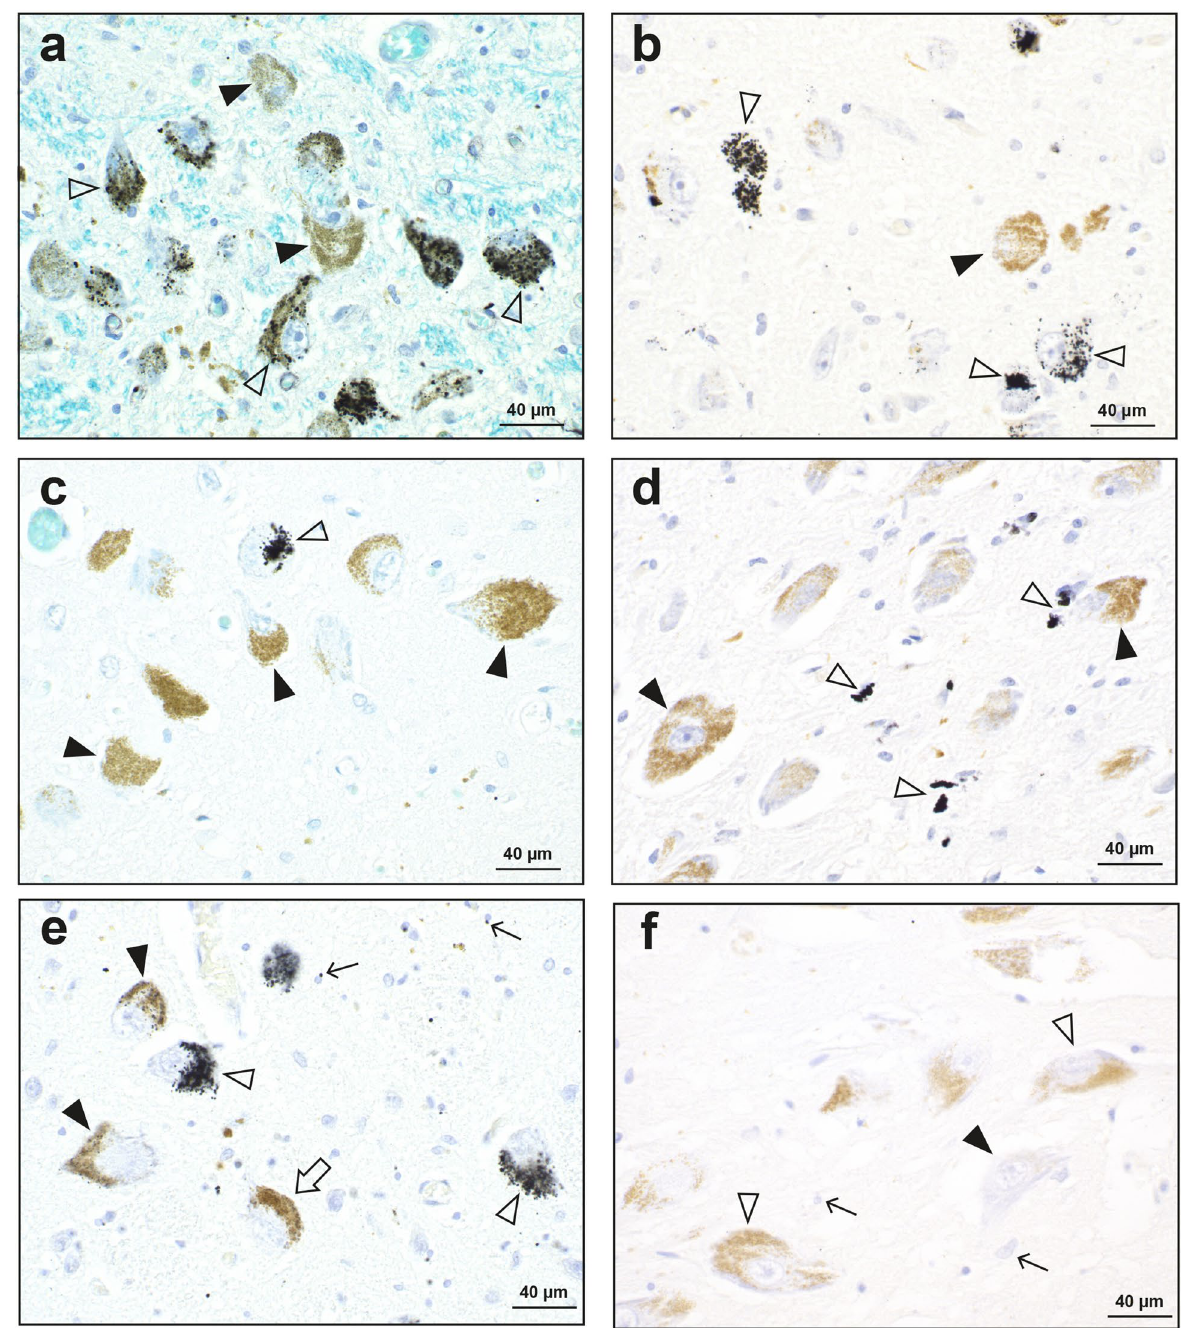
Figure 4. Autometallography of the locus ceruleus. ( a ) Black AMG PTE granules are seen in the majority of locus ceruleus neurons (open arrowheads). Some locus ceruleus neurons contain no AMG PTEs (closed arrowheads). MS18. AMG/LFB/CV. ( b ) Many locus ceruleus neurons contain AMG PTE granules (open arrowheads). Some locus ceruleus neurons contain no AMG PTEs (closed arrowhead). MS09. AMG/H. ( c ) A few locus ceruleus neurons contain AMG PTEs (arrowhead). Most locus ceruleus neurons do not contain AMG PTEs (closed arrowheads). MS14. AMG/LFB/CV. ( d ) Scattered black AMG PTE granules (open arrowheads) are present in the neuropil of the locus ceruleus. Locus ceruleus neuronal cell bodies with brown neuromelanin granules (closed arrowheads) contain no AMG PTEs. MS07. AMG/H. ( e ) In the locus ceruleus of a control, some neurons contain abundant AMG PTEs, obscuring the neuromelanin (open arrowheads). Other neurons contain scattered AMG PTEs within neuromelanin (closed arrowheads), and some are AMG PTE-free (open arrow). Scattered oligodendrocytes (thin arrows) contain small AMG PTE granules. CN12. AMG/H. ( f ) No AMG PTEs are present in the substantia nigra compacta in the midbrain in the same brain as ( e ), either in pigmented neurons (open arrowheads), non- pigmented neurons (closed arrowhead), or glial cells (arrows). CN12.